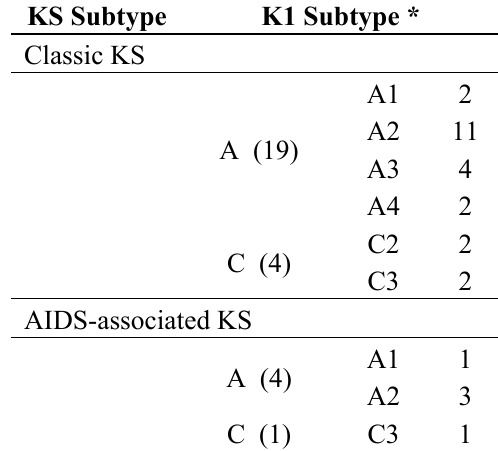
Table 2. KSHV K1 genotypes between classic KS and AIDS KS.